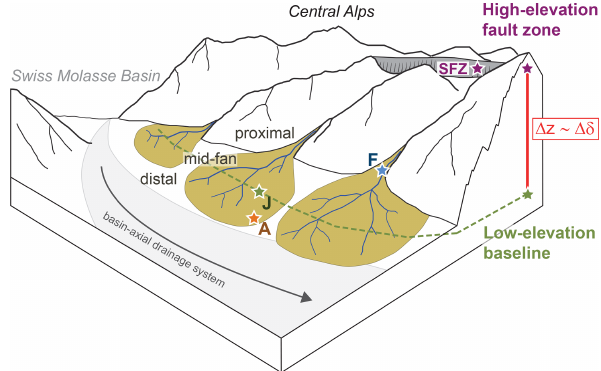
Figure 4. Simplified sketch of the mid-Miocene Swiss Mo- lasse Basin (SMB, 15–14Ma) showing the distribution of alluvial megafans along the northern Alpine flank. The sampled sections are located at different paleoaltitudes within the megafan deltas, which results in an internal elevation difference of ca. 300m ( ± 100m; see text for discussion). We use the difference in precipitation δ 18 O values ( (cid:49)δ ) between the low-elevation SMB records (F, J, A; see Fig. 1) and the high-elevation (projected) Simplon Fault Zone (SFZ) to calculate the elevation difference ( (cid:49)z ) between these sites. The grey arrow depicts the paleo-discharge direction of the drainage system. Distribution of alluvial fans is adopted from Berger et al.